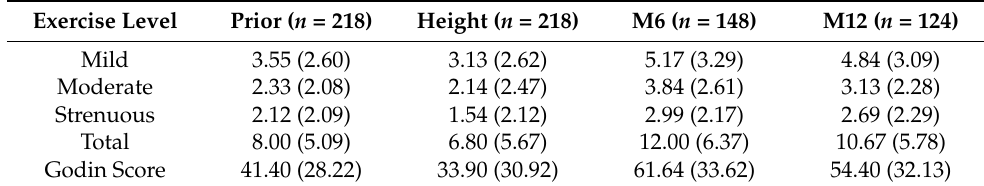
Table 4. Mean (SD) of number of exercise sessions by